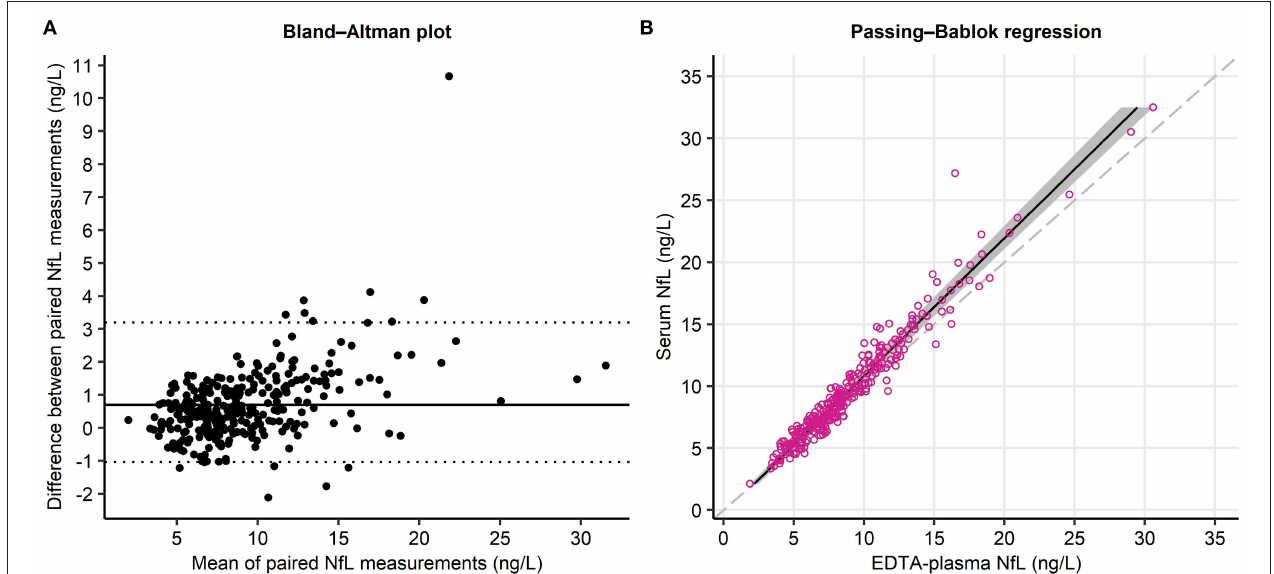
FIGURE 1 | Agreement analyses of NfL measured in different biological matrices. (A) Bland–Altman plot: The solid line indicates the mean of the paired differences, the dotted lines represent the Sfakianakis–Verginis limits of agreement. (B) Passing–Bablok regression analysis: Red dots indicate individual samples ( n = 299), the dashed line represents the equation x = y (identity line), and the gray area shows the 95% CIs of the regression line.